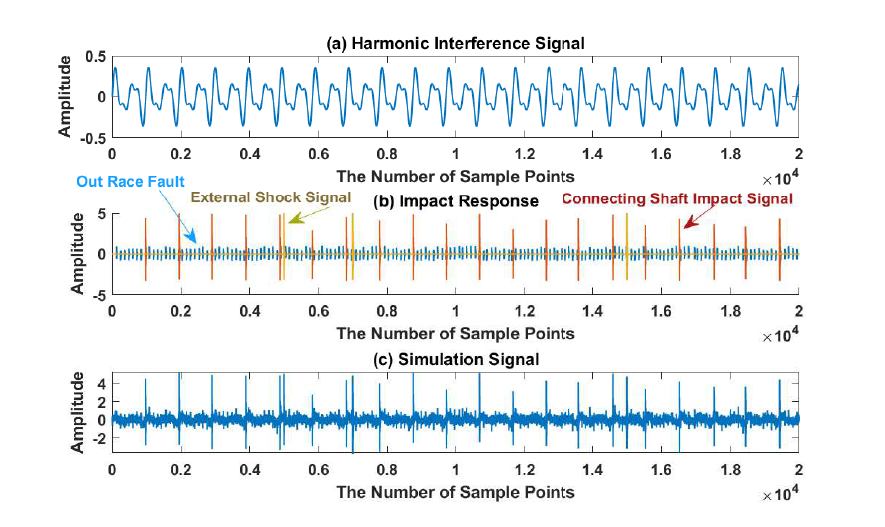
Figure 5. The simulated signal: ( a ) harmonic interference; ( b ) impulse responses excited by defects in the bearing; ( c ) the synthesis signal.